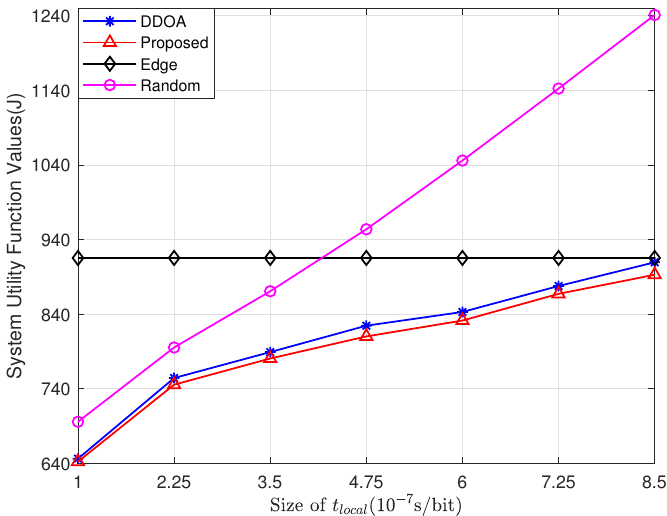
Figure 7. The system utility function values under different processing capabilities t local of the local devices for different offloading